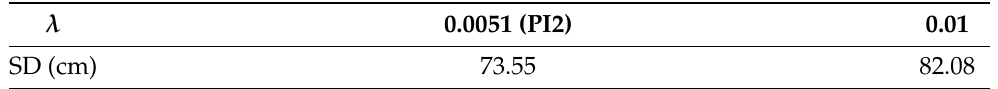
Table 1. SOD with different values of λ